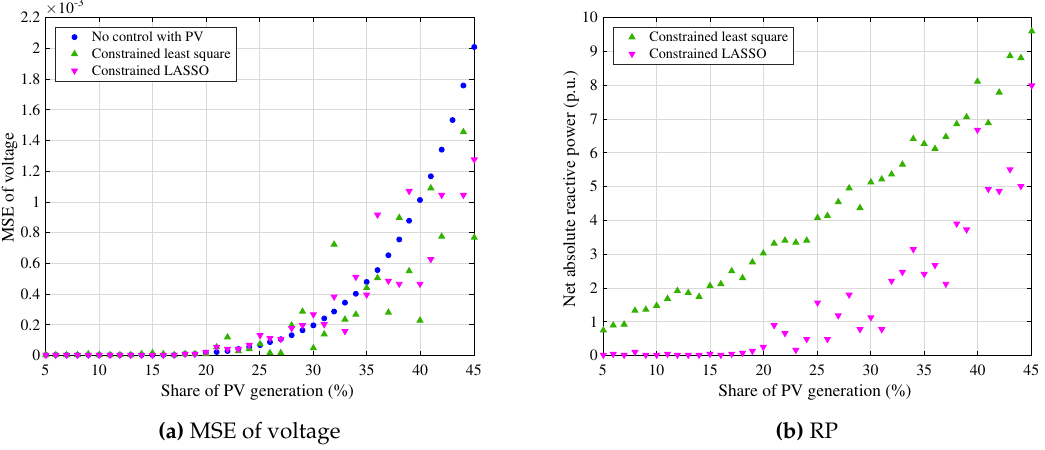
Figure 5. On-demand distribution of PV power generators at each consumer bus of the 39-bus power system. PV is assigned only at consumer buses with real power demand. The real power generation of PV at each bus is proportional to the consumer real power demand at the bus, where the (PV/demand) ratio is equal at each PV-enabled bus; snap results of the share ratio range from 5% to 45%; MSE of voltage: Mean square error of voltage from the reference voltage; RP: Net absolute reactive power generation from PV